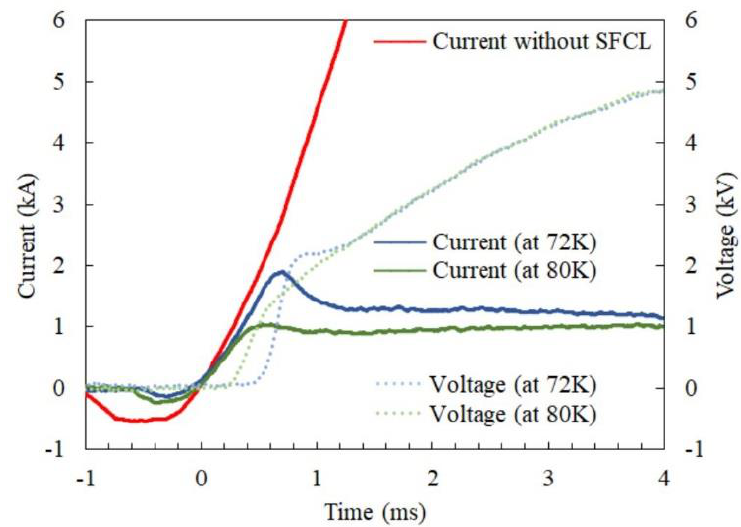
Figure 8. A comparison of current courses in the circuit with and without the limiter.